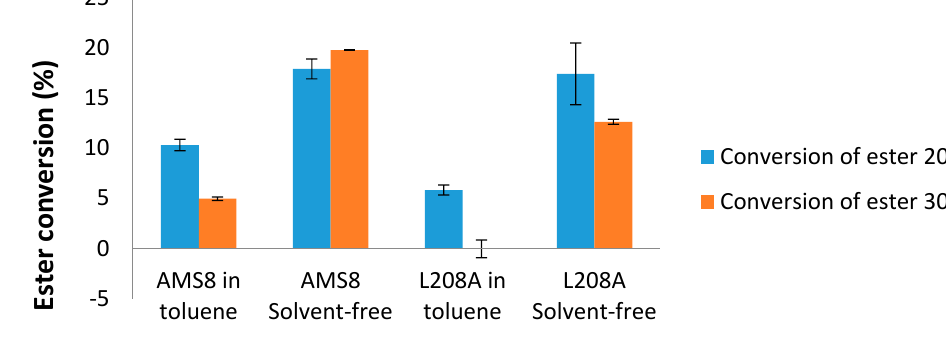
Figure 9. Esterification conversion rate of mutant L208A with and without toluene using 5 mg of protein per reaction at 20 °C and 30 °C.